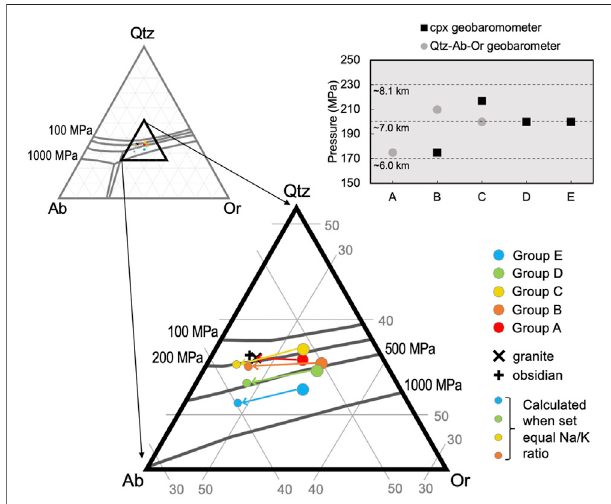
FIGURE 9 | Quartz-albite-orthoclase (Qtz-Ab-Or) ternary geobarometer (Holtz et al., 1992) and clinopyroxene geobarometer (Jorgenson et al., 2021) results for Rattlesnake Tuff (RST) high-silica rhyolite (HSR) Groups. Large colored circles in the Qtz-Ab-Or ternary results when plotting CIPW normative compositions for each HSR Group. The obsidian sample with Group A composition and granite sample with a composition similar to Group A are also plotted on the Qtz-Ab-Or ternary. The low LOI (0.6%) from the XRF analysis of the obsidian sample indicates that the nearly 1:1 Na/K ratio is representative of the true, original Na/K ratio of Group A magma. Thus, all Na/ K ratios are adjusted to 1:1 for all other Groups and plotted on the Qtz-Ab-Or ternary. Results from the Qtz-Ab-Or geobarometer are compared to results from the clinopyroxene geobarometer (top right) for each HSR Group. The Qtz-Ab-Or pressures for Groups D (~500 MPa) E (~600 MPa) are excluded from the graph, because they are considered erroneously